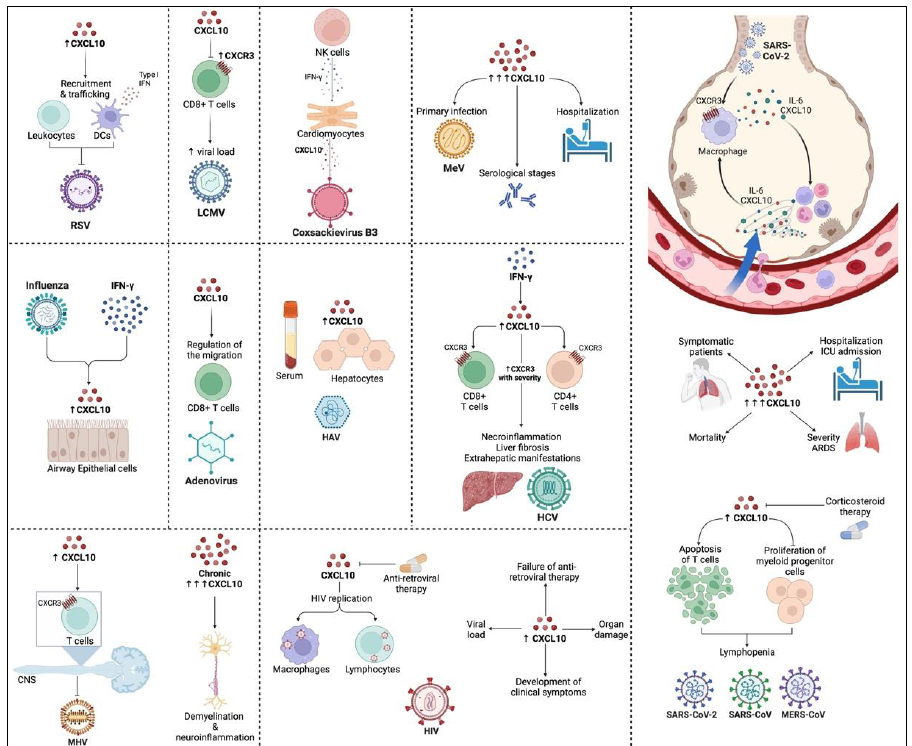
Figure 1. Role of CXCL10 during RNA viral infections. ARDS: acute respiratory distress syndrome, CNS: central nervous system, HAV: hepatitis A virus, HCV: hepatitis C virus, HIV: human immunodeficiency virus, LCMV: lymphocytic choriomeningitis virus, MERS-CoV: middle east respiratory syndrome coronavirus, MeV: measles virus, MHV: murine hepatitis virus, RSV: respiratory syncy- tial virus, SARS-CoV: severe acute respiratory syndrome coronavirus, SARS-CoV-2: severe acute respiratory syndrome coronavirus